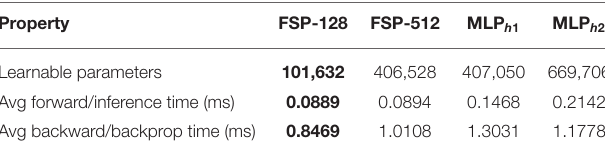
TABLE 9 | The spatial and computational complexity of different architectures for learning MNIST and FashionMNIST.